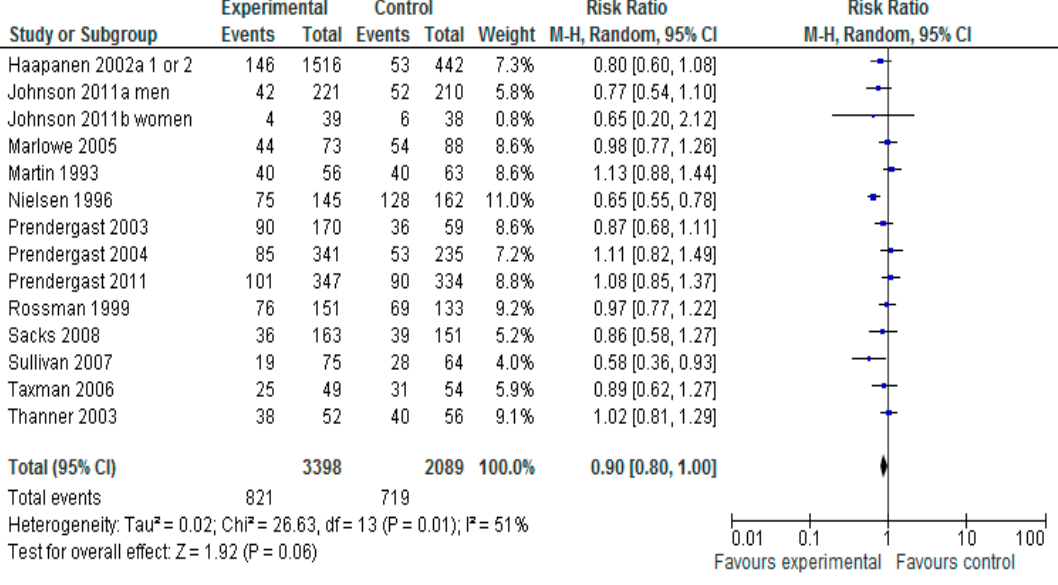
Figure 4. Does any type of Non-Pharmacological intervention reduce subsequent drug use?